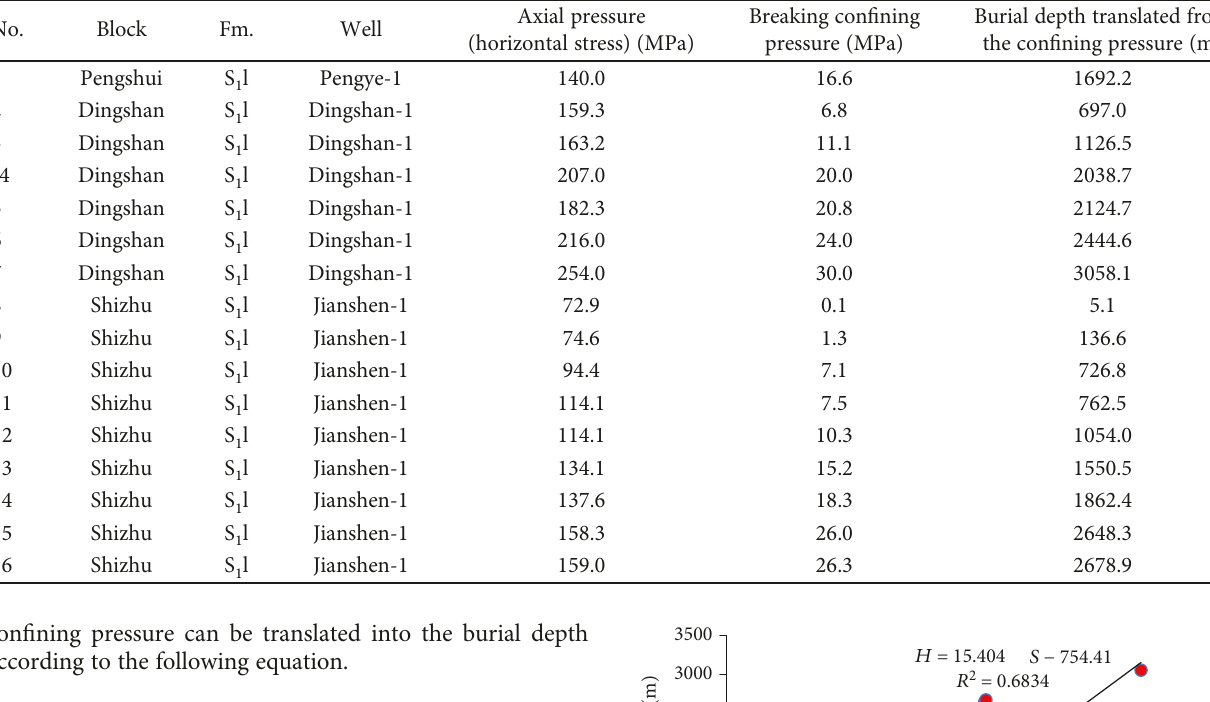
Table 4: The results of the triaxial unloading experiments, including the breaking con fi ning pressure and the burial depth calculated when a certain axial pressure is applied to the rock (namely, the horizontal stress). See Figure 1 for the well locations. No. Fm.